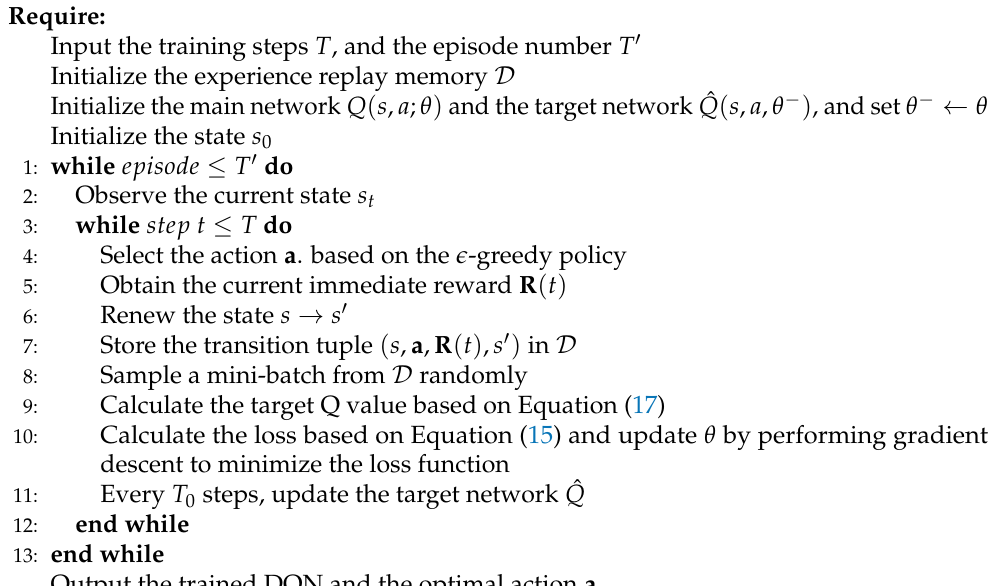
Algorithm 1 D3QN-based task offloading